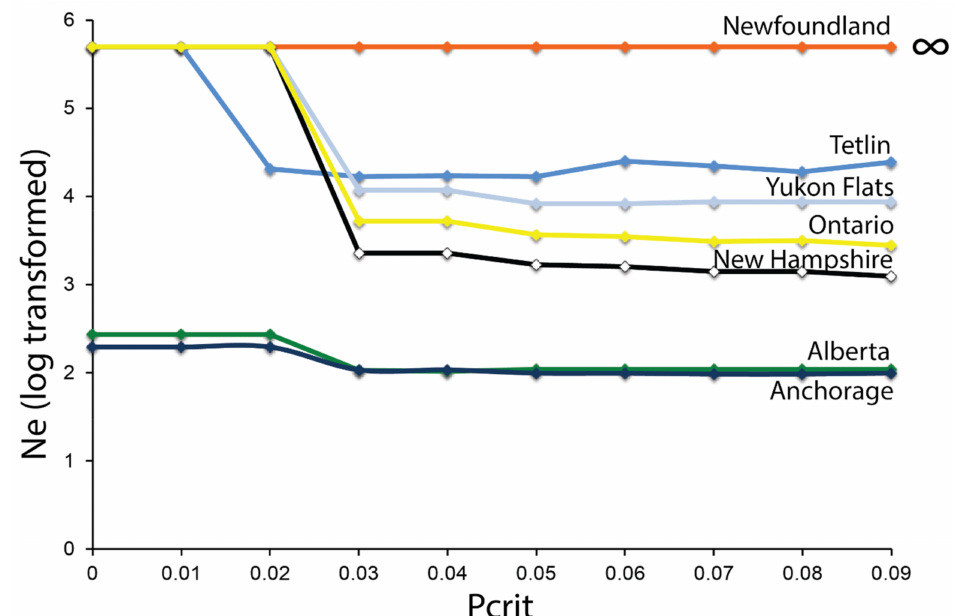
Figure 6. Effective population size (Ne) estimates as a function of excluding rare alleles (Pcrit) in rusty blackbirds sampled across their North American distribution. Point estimates of Ne are log transformed with values >5 signifying infinitely large estimates. Colors correspond to Figure